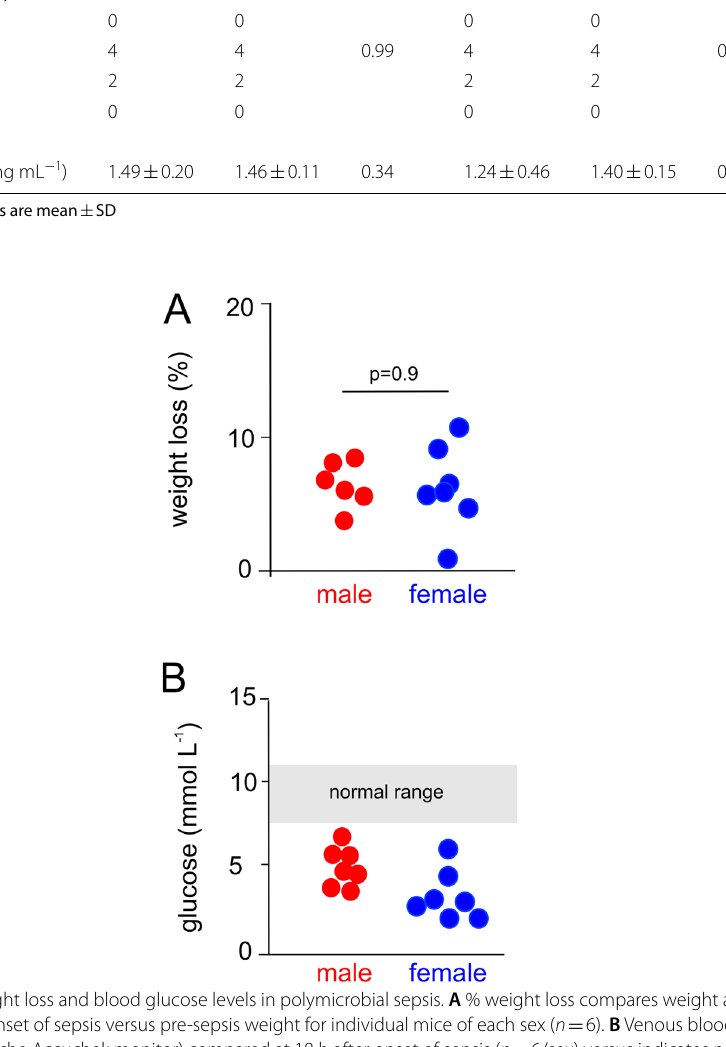
Table 1 Clinical severity and cardiac injury following isovolaemic polymicrobial murine sepsis